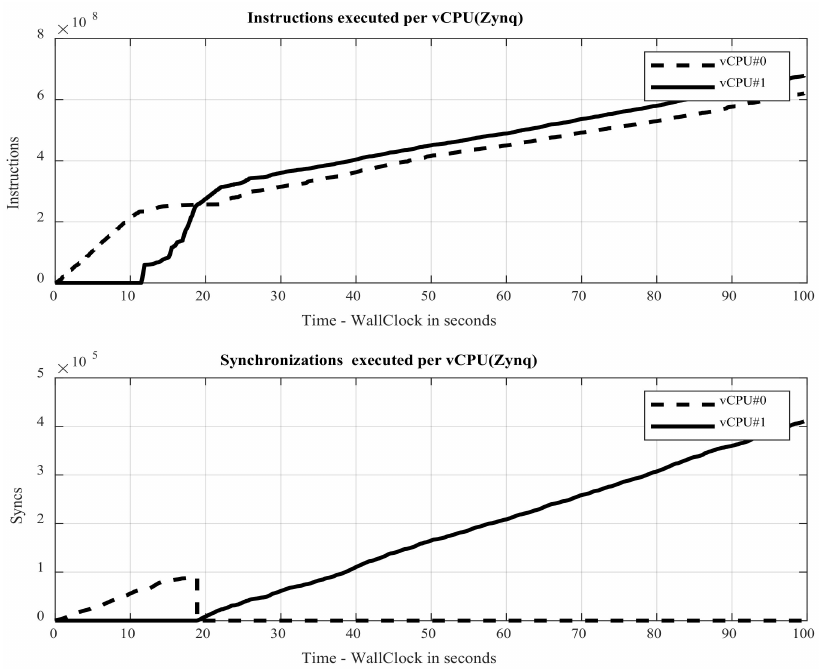
Figure 11. Sync management as a function of vCPUs: ( Top ) instructions executed per vCPU; ( Bottom ) synchronization executed per